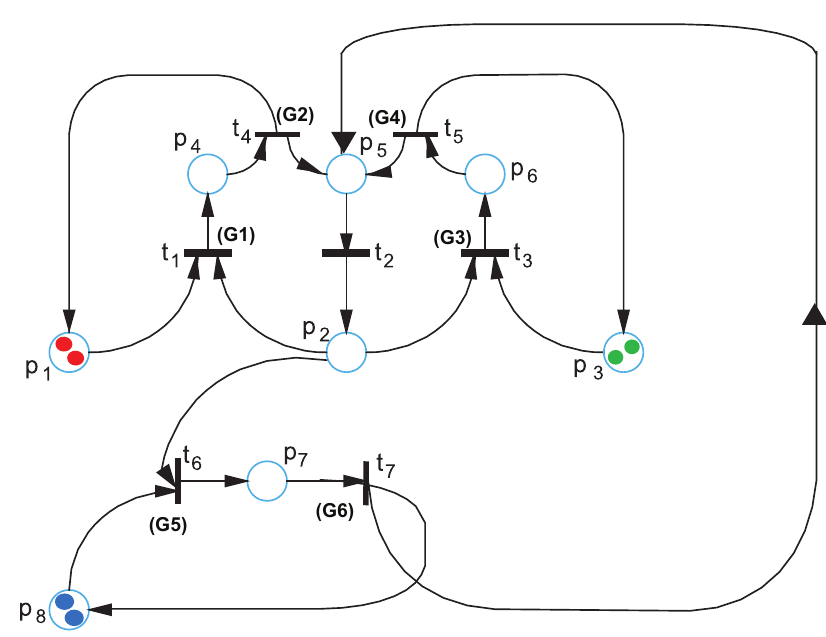
Figure 4. The dominant server queue (DSQ)